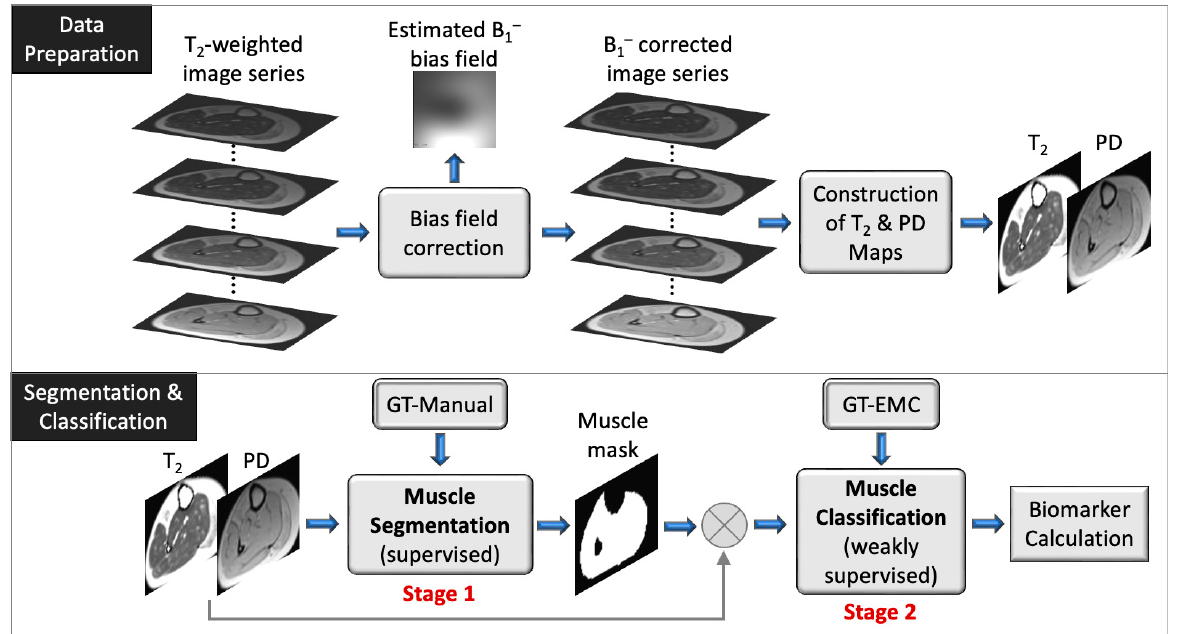
Figure 2. Schematic overview of data preparation (top) and segmentation and classification pipeline (bottom). The muscle segmentation (stage 1) and muscle classification (stage 2) are also described in the Supplementary Materials. The biomarker is defined by Equation (4). GT: ground truth; PD: proton